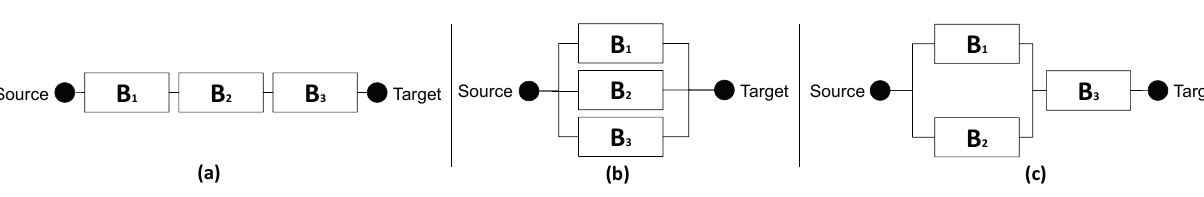
Figure 4. RBD organized in ( a ) series; ( b ) parallel and ( c )